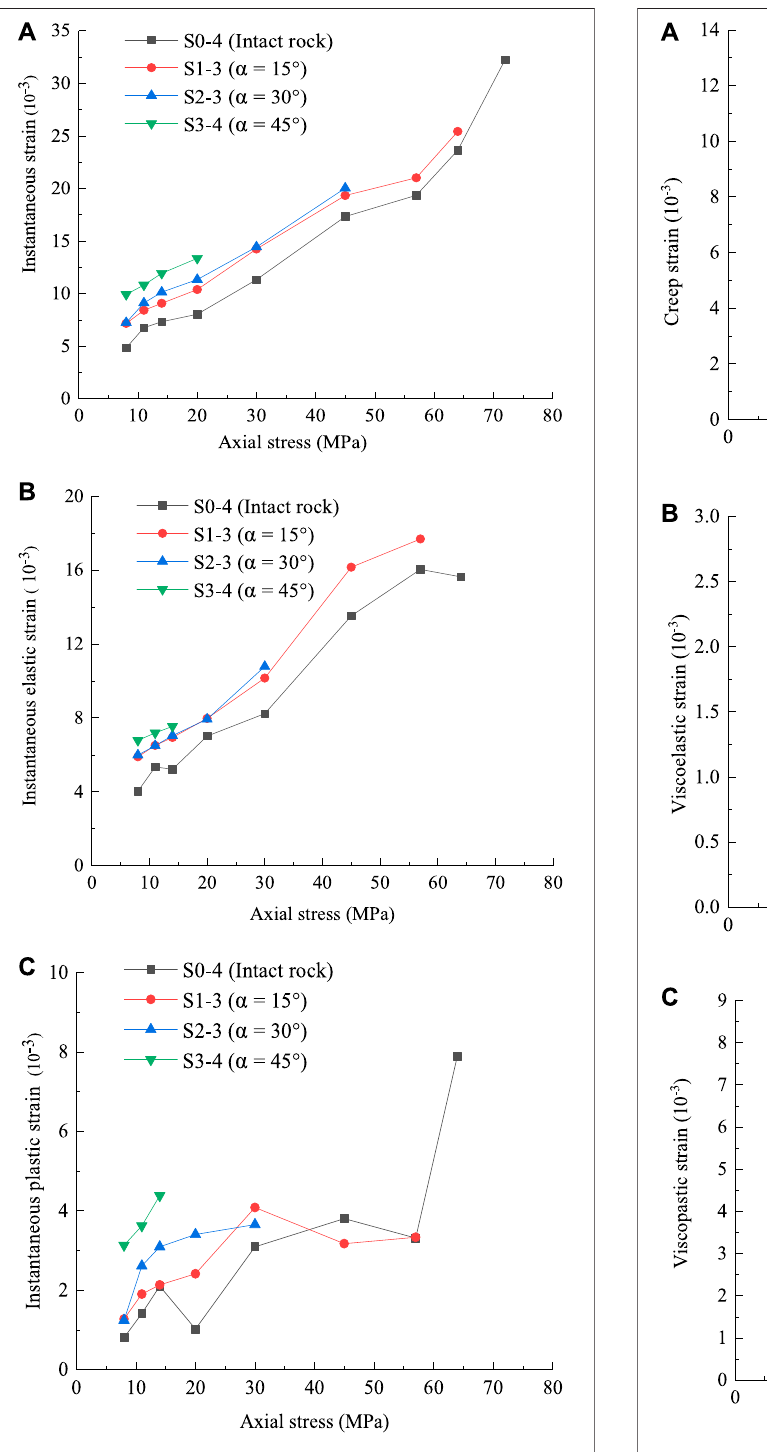
FIGURE 11 | (A) Instantaneous strain, (B) instantaneous elastic strain, and (C) instantaneous plastic strain from the fi rst to the last stress levels.